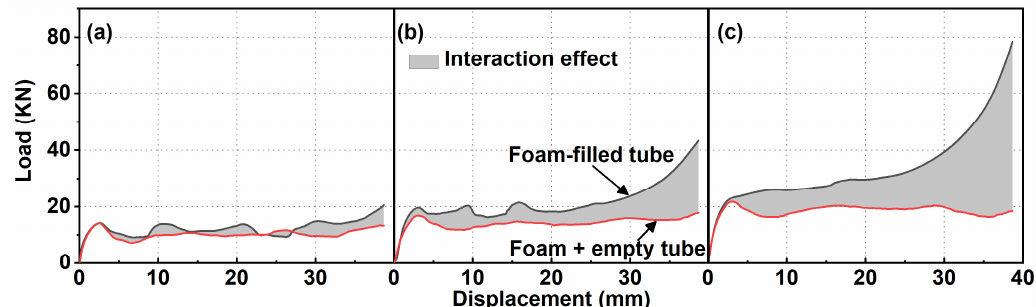
Figure 7. Foams fabricated under different pressures on the effect of interaction Test No. 1 ( a ), Test No. 5 ( b ), and Test No. 12 ( c ).